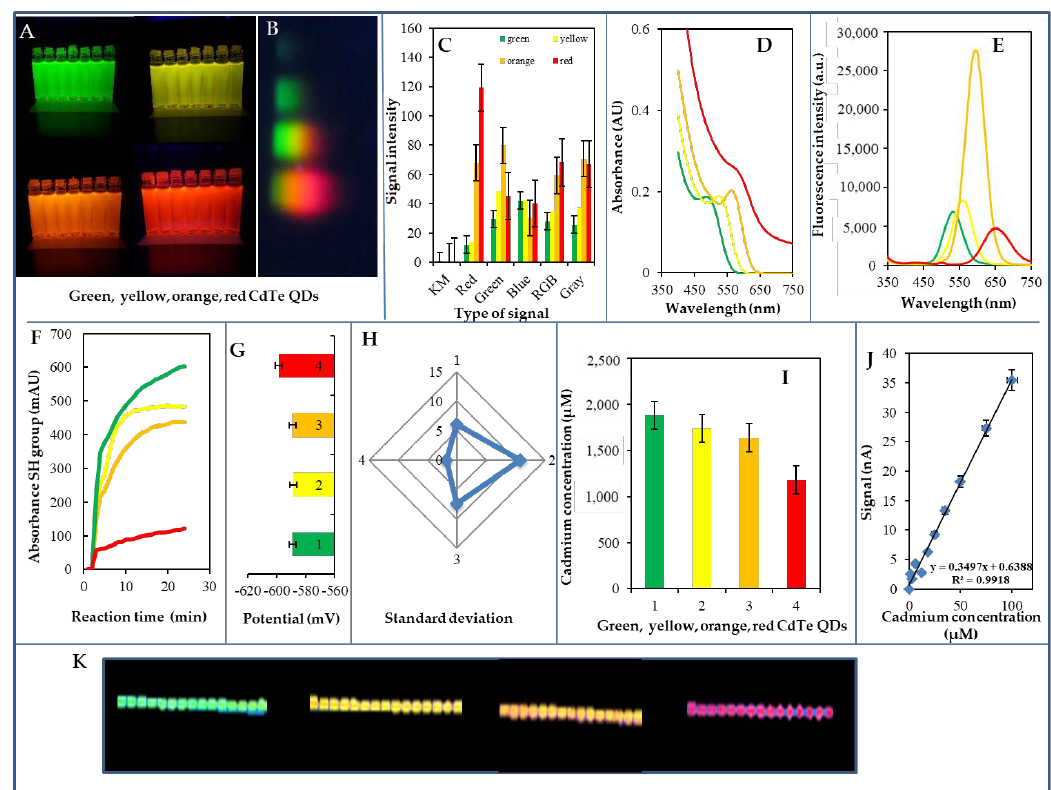
Figure 1. Biophysical characteristics of prepared CdTe QDs used for environmental experiment—summarizing information from all measurements. ( A ) Fluorescence of the prepared dots under ultraviolet (UV) light (310 nm) used in the experiment described above. ( B ) Typical profile of individual types of QDs on sodium dodecyl sulphate-polyacrylamide gel electrophoresis (SDS-PAGE) gel after separation (1.5 h, 100 V). ( C ) The created profile was analysed using the COLOR test program developed by us. The intensities of individual pixels are plotted in different color profiles. ( D ) Spectrophotometric characterization of QDs, plastic cuvette 1 cm track, blank solution—water. ( E ) Fluorometric characteristics of QDs measured in a UV transparent plate at excitation of 250 nm. ( F ) Typical reaction QDs curves in the presence of Ellman’s reagent for detection of free SH groups. ( G ) Changes in the peak potential of Cd in the electrochemical analysis of QDs. ( H ) Changes in standard deviation of Cd current signal during electrochemical analysis of QDs (1—green, 2—yellow, 3—orange, 4—red). ( I ) The cadmium concentration in QDs. ( J ) Typical calibration curve for cadmium analysis in organic form. ( K ) QDs deposited on paper and visualized at 365 nm the photograph made at lightening. All experiments were performed in five replicates, the displayed data being the average values. Further experimental details are described in the Materials and Methods section.